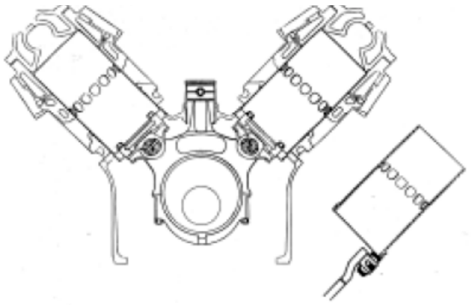
Figure 12. The Rolls-Royce Crecy sleeve valve drive arrangement. Reproduced with permission from New Zealand Rolls-Royce & Bentley Club Inc Copyright Publisher, 2007.